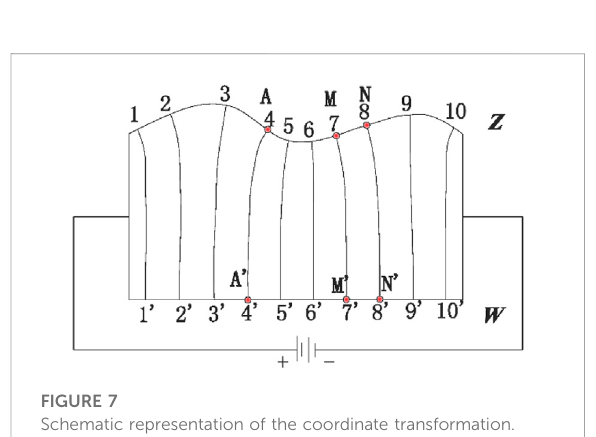
FIGURE 7 Schematic representation of the coordinate